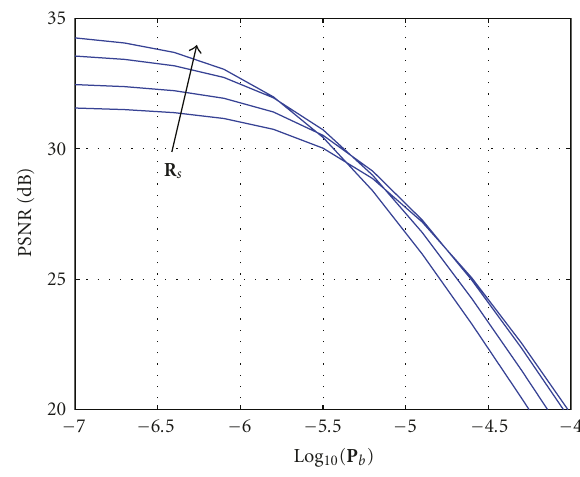
Figure 4: Typical universal rate-distortion characteristics for a single-layer H.263+ coder, PSNR ( R s , P b ).